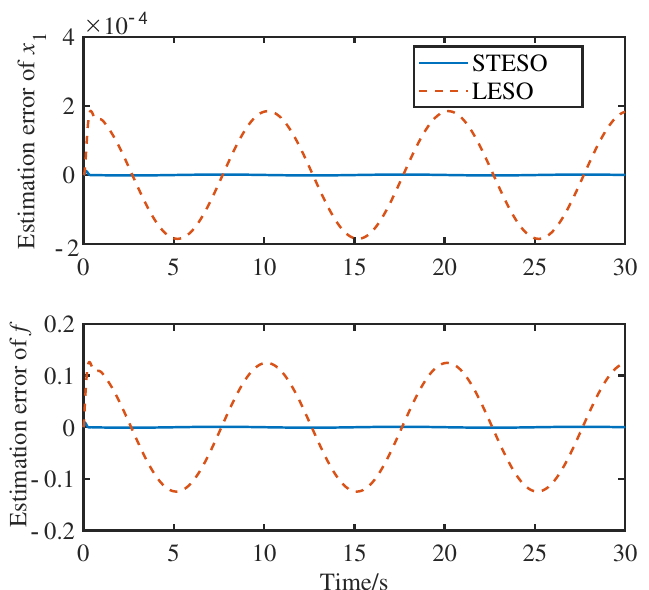
Figure 4. Simulation results of sinusoidal disturbance—estimation error: STESO (solid line); LESO (dashed